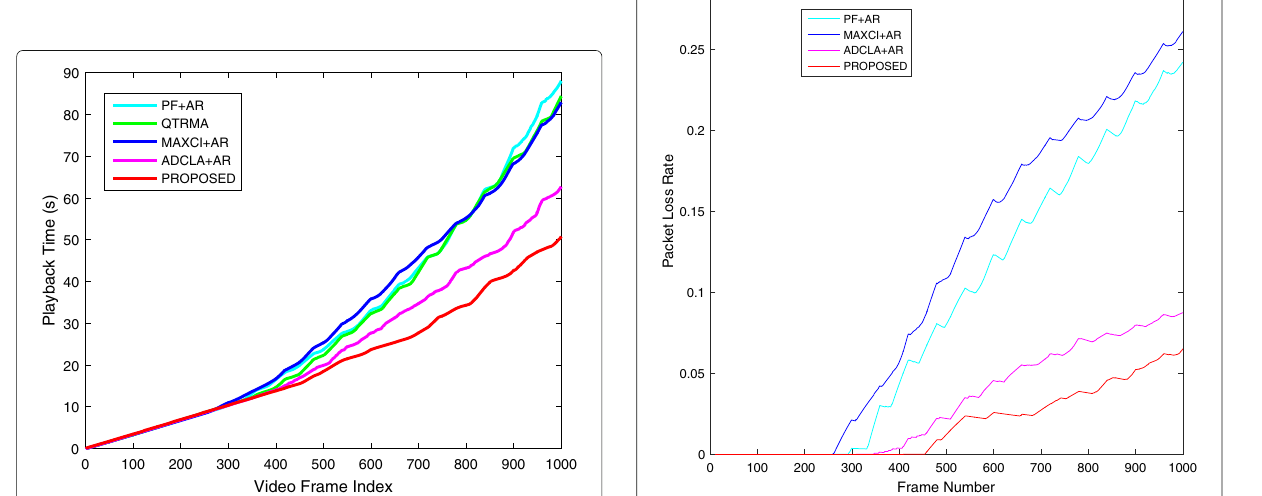
Fig. 6 Average playback time of all the clients for each frame for different algorithms